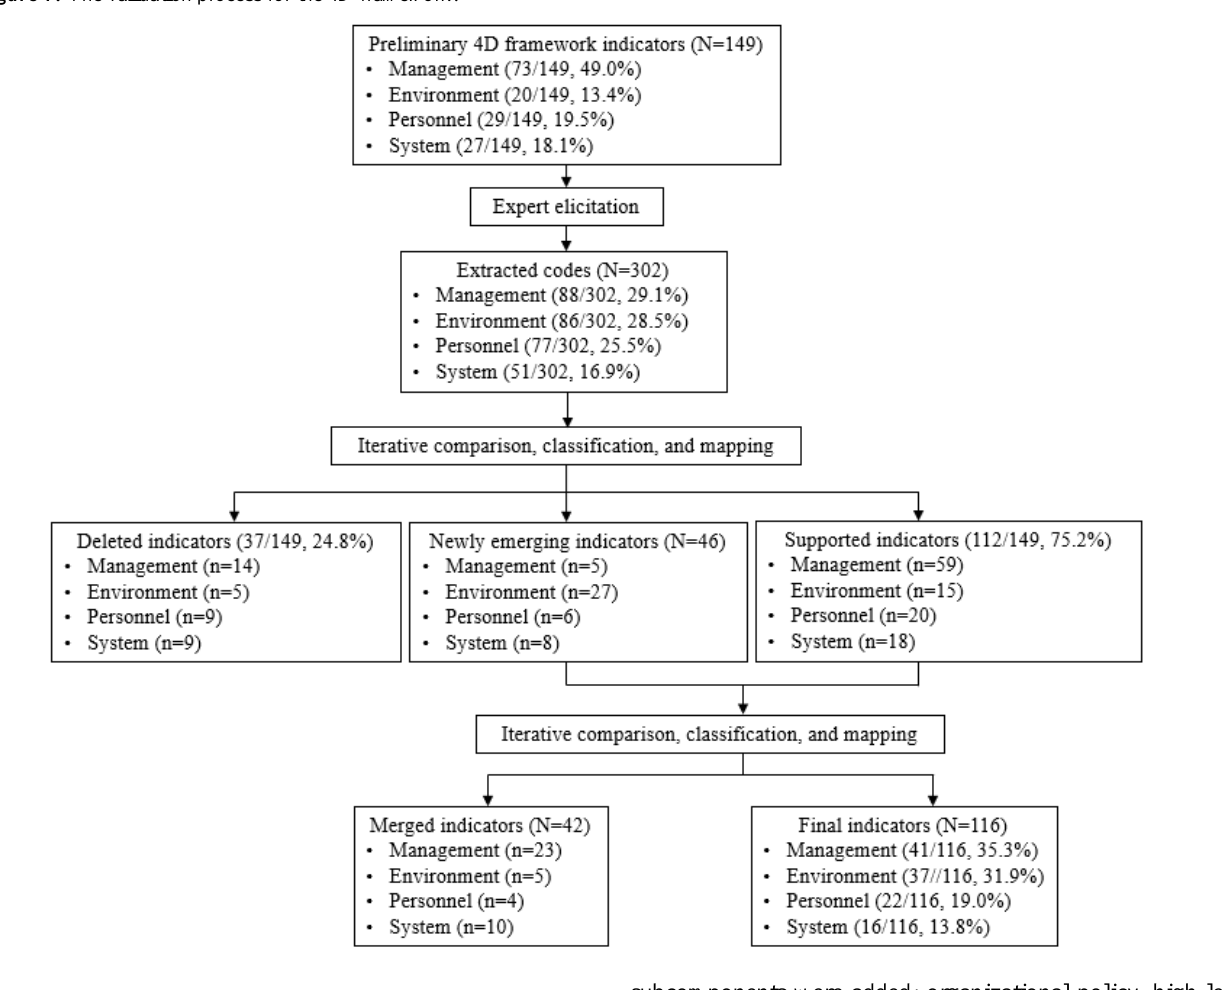
Figure 1. The validation process for the 4D